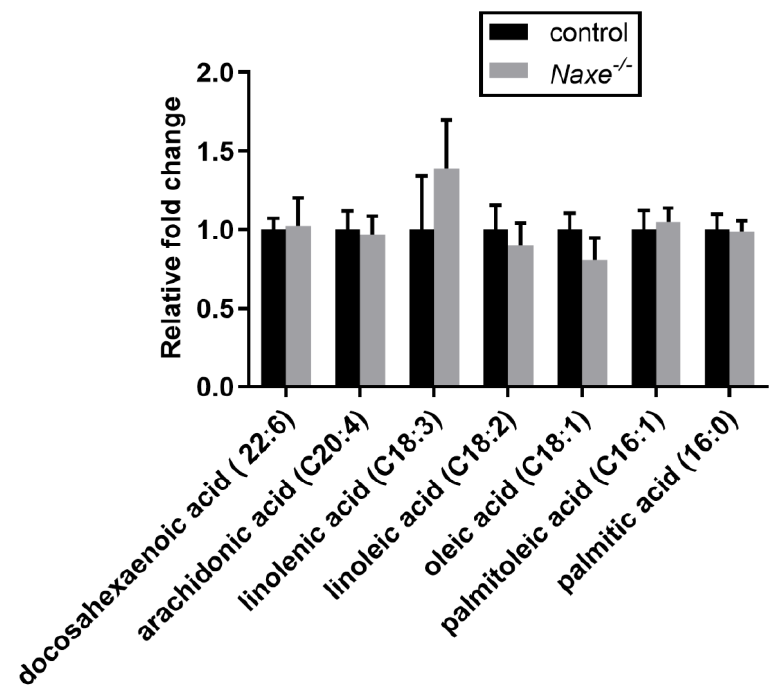
Figure 7. Effect of NAXE knockout on fatty acid metabolism. Relative abundance of detected free fatty acids. Mean ± SE; n = 6 mice per group.